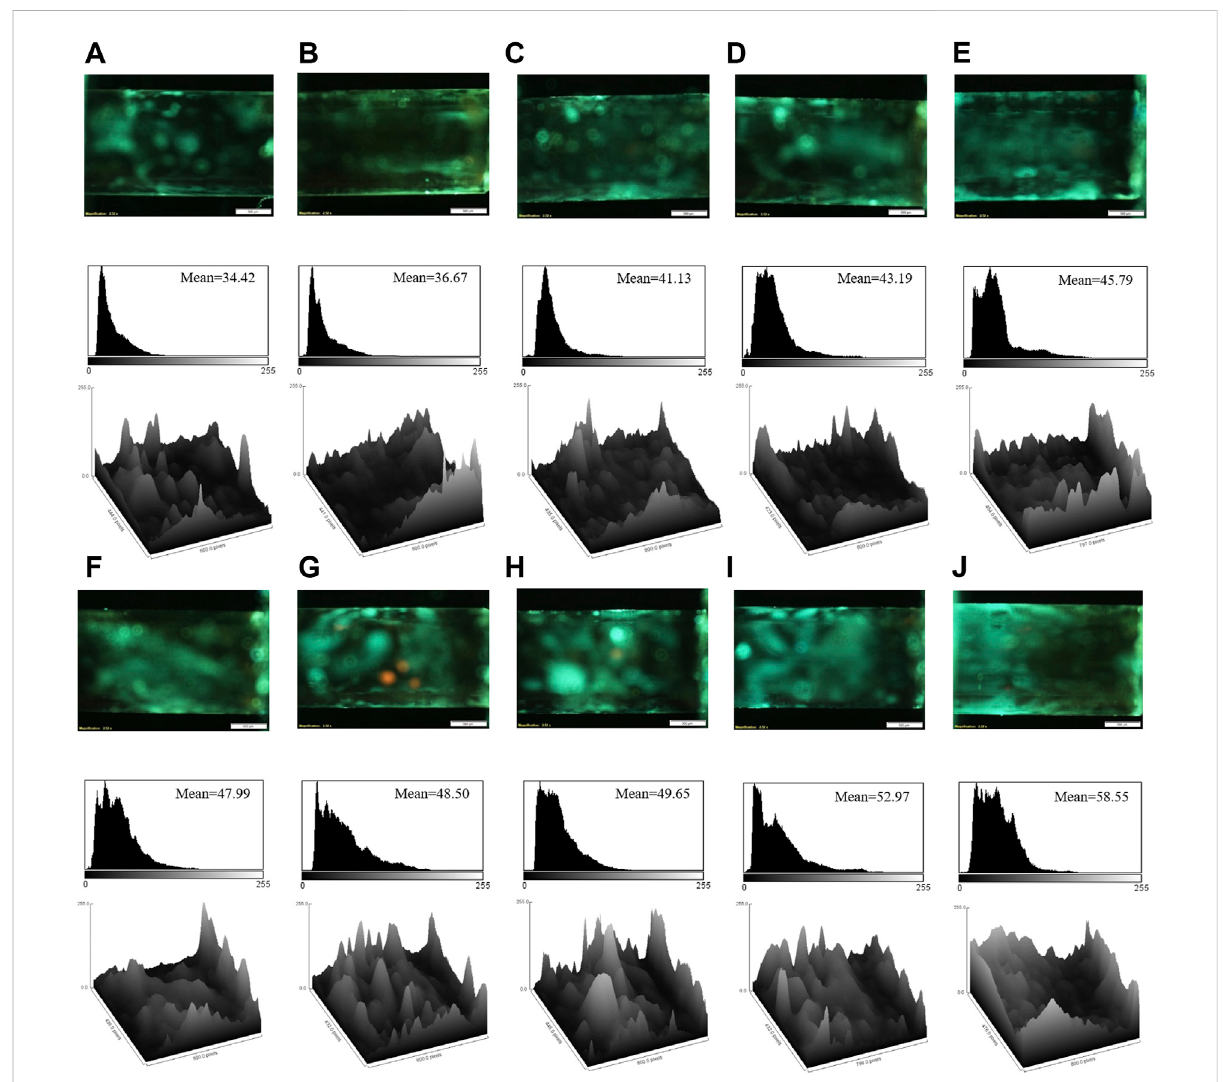
The fl uorescence images, corresponding mean brightness values, and surface plots of the aptasensor in the presence of the different concentrations of cocaine: (A) 100 pM; (B) 500 pM; (C) 10 nM; (D) 50 nM; (E) 250 nM; (F) 2 μ M; (G) 4 μ M; (H) 8 μ M; (I) 50 μ M; (J) 600 μ M. Scale bar: 500 μ